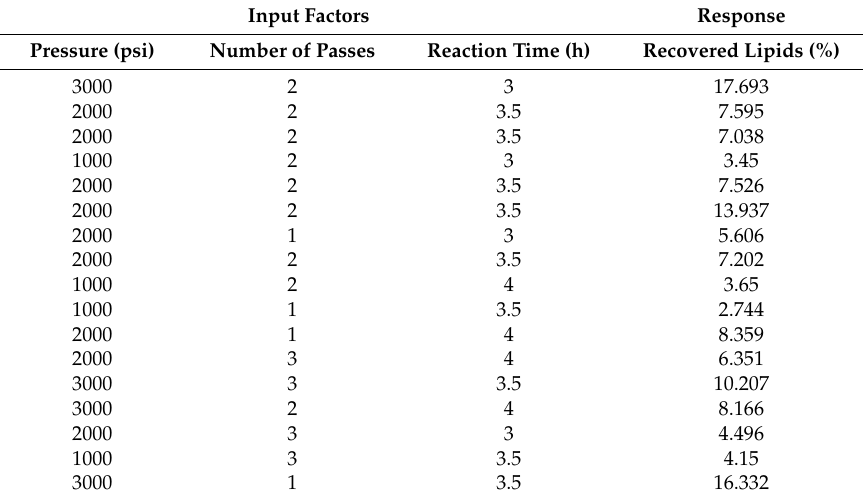
Table 2. Experimental results for both output and input parameters.